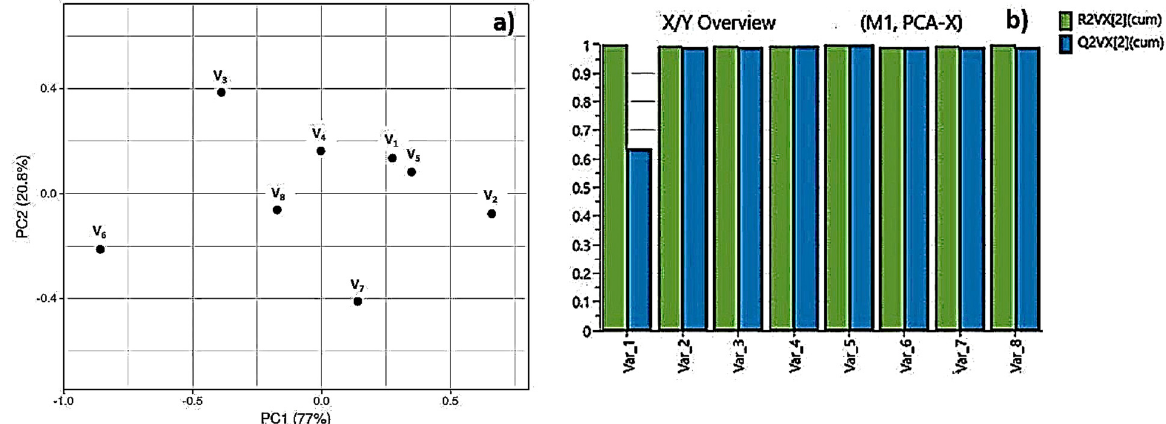
Figure 11. PCA scores scatter plots of FTIR spectra in the region from 600—4600 cm − 1 ; ( a ) V1—F = 1.663 J/cm 2 , V = 1.7 mm/s; V2—F = 1.663 J/cm 2 , V = 3.8 mm/s; V3—F = 1.663 J/cm 2 , V = 16 mm/s; V4—F = 0.831 J/cm 2 , V = 6.0 mm/s; V5—F = 0.831 J/cm 2 , V = 1.7 mm/s; V6—F = 0.831 J/cm 2 , V = 16 mm/s; V7—F = 0.831 J/cm 2 , V = 3.8 mm/s; V8—F = 1.663 J/cm 2 , V = 0.6 mm/s; ( b ) The Summary of plot fit of the PCA model for component R2 and Q2.